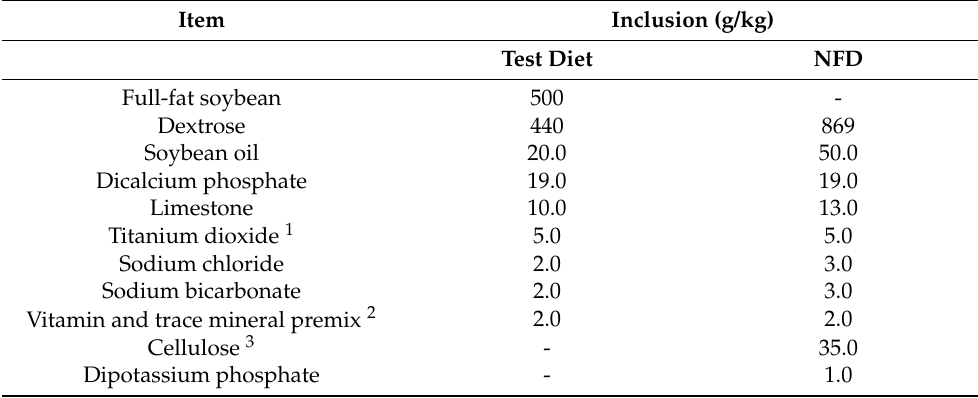
Table 3. Composition of the test diet and nitrogen-free diet (NFD) (g/kg, as fed basis) used in the amino acid digestibility assay.